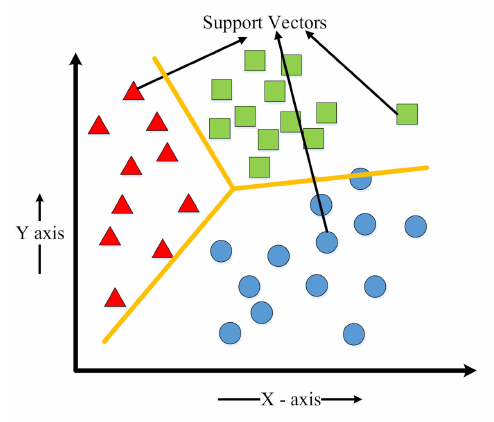
Figure 2. Multi-classification based on